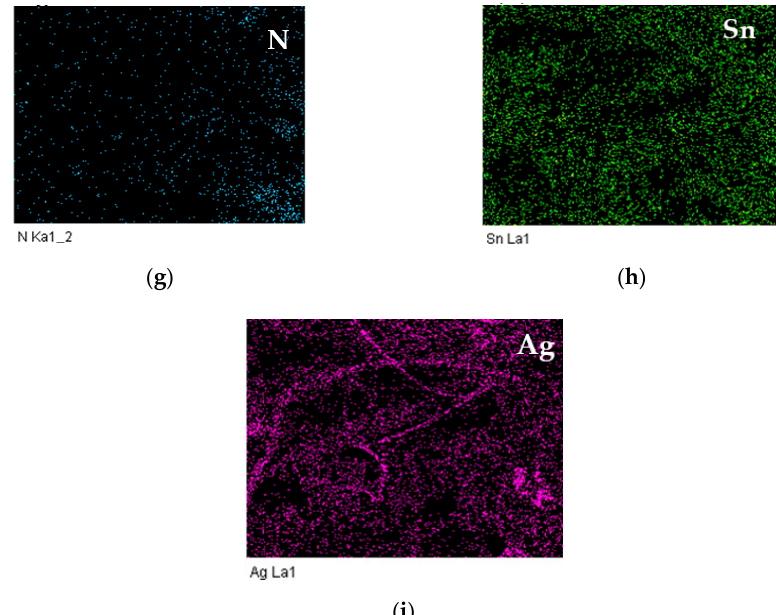
Figure 4. SEM images of ( a ) pristine SnO 2 film, ( b ) low-magnification image of Ag MWs/PPy/SnO 2 ternary composite film (white arrows indicated the Ag MWs), ( c ) high-magnification image of Ag MWs/PPy/SnO 2 ternary composite film, ( d ) image of the fracture in ( b , e – i ) its EDX mapping with elements for C, O, N, Sn, and Ag.